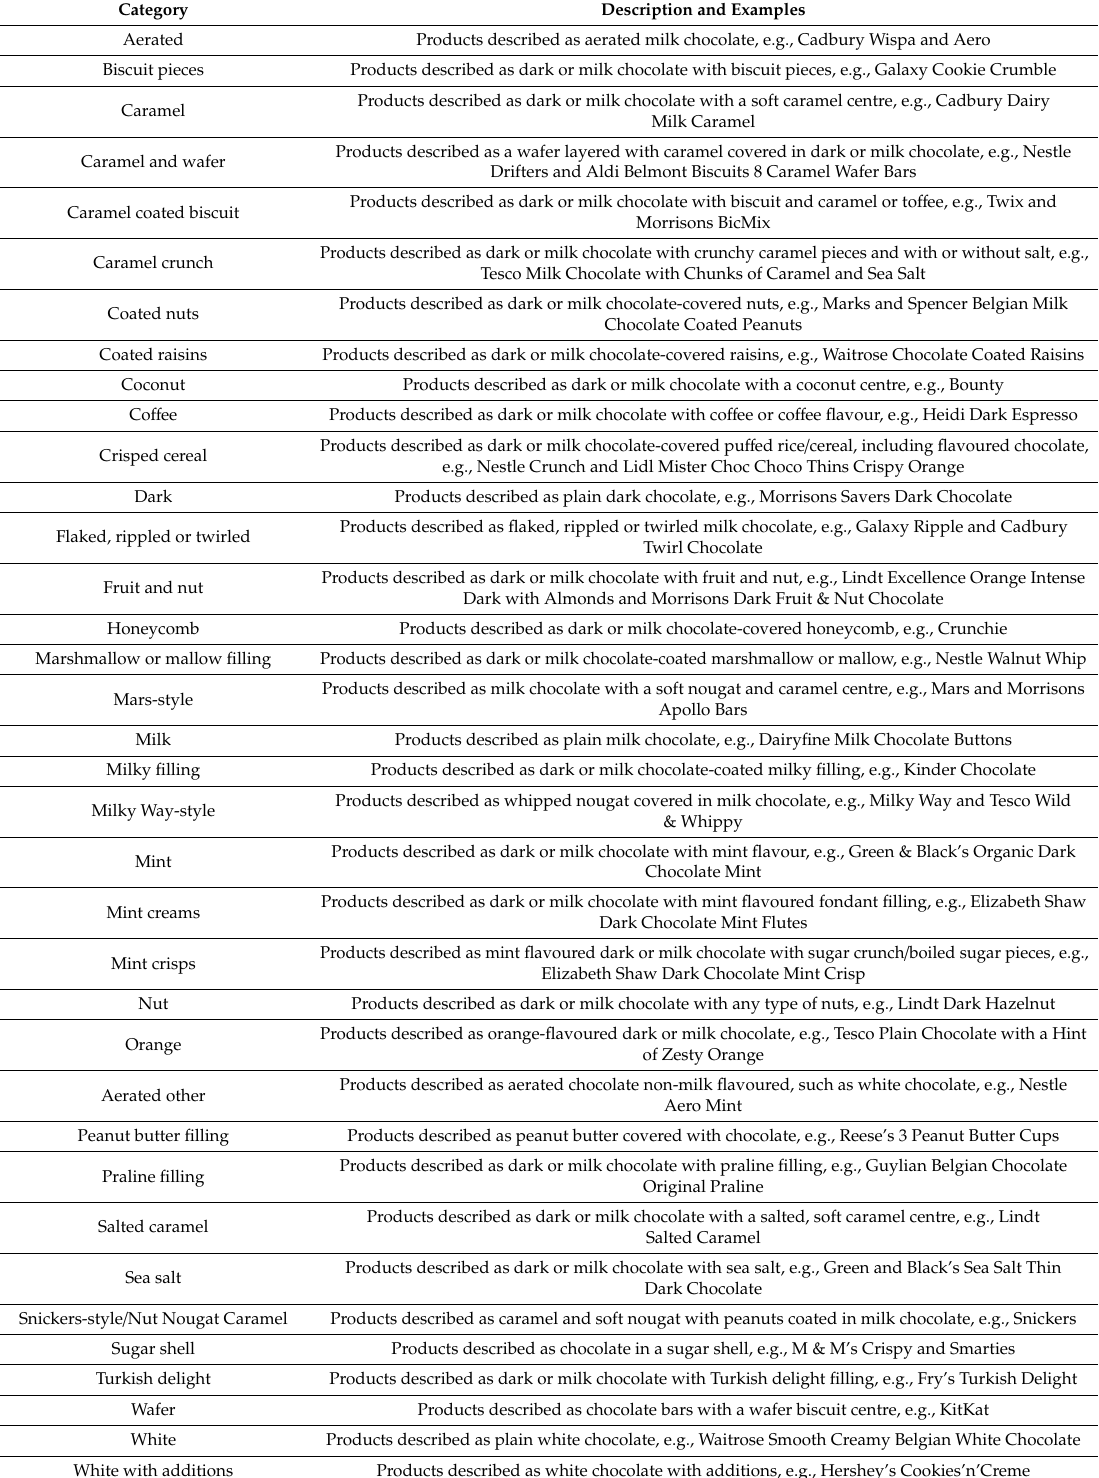
Table 1. Descriptions and examples of chocolate confectionery